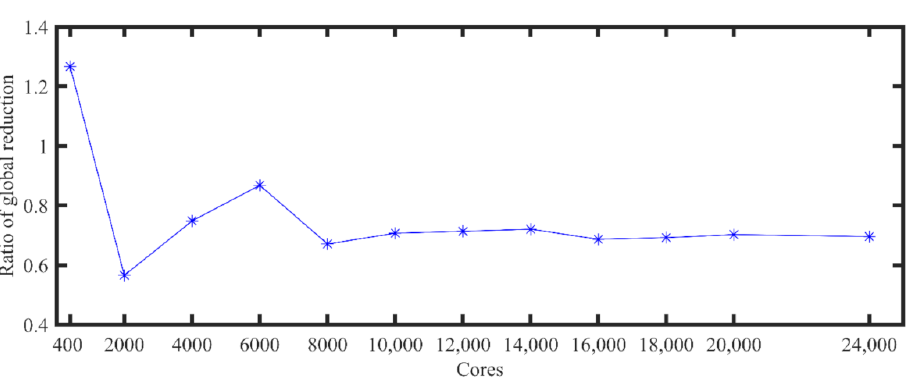
Figure 6. Ratio of the percentage of the global reduction (MPI_Allreduce) time of the total execu- tion time determined using the CA-PCG and PCG solvers. In particular, the barotropic mode in GYRE_PCG accounted for approximately 97–99% of the total execution times when scaled to more than 8000 processes (Figure 7). After using the new CA-PCG solver, the percentage decreased slightly to approximately 92–96%. Even though the reduction in the percentage does not seem notable, the execution time of the barotropic mode decreased from more than 17,000 s to less than 6000 s (figure not